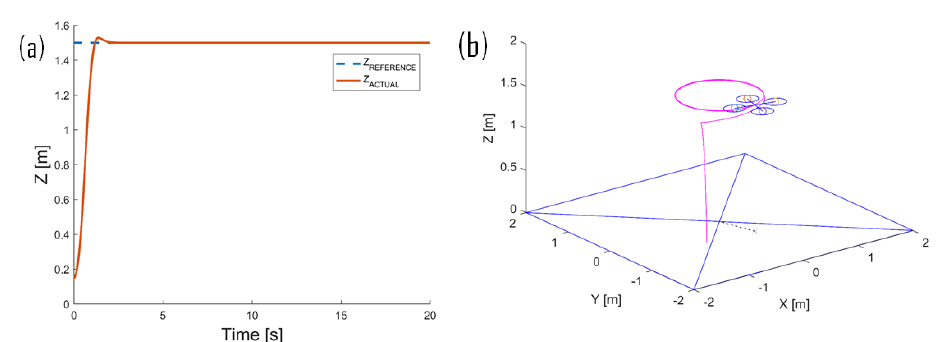
Figure 10. Experiment No. 2: Test of the performance of circle-shaped path tracking for the X-4 Flyer II drone model in a system with BELBIC altitude controller: ( a ) reference (desired) and actual (measured) positions of the UAV in the Z axes and ( b ) flight trajectory in 3D.